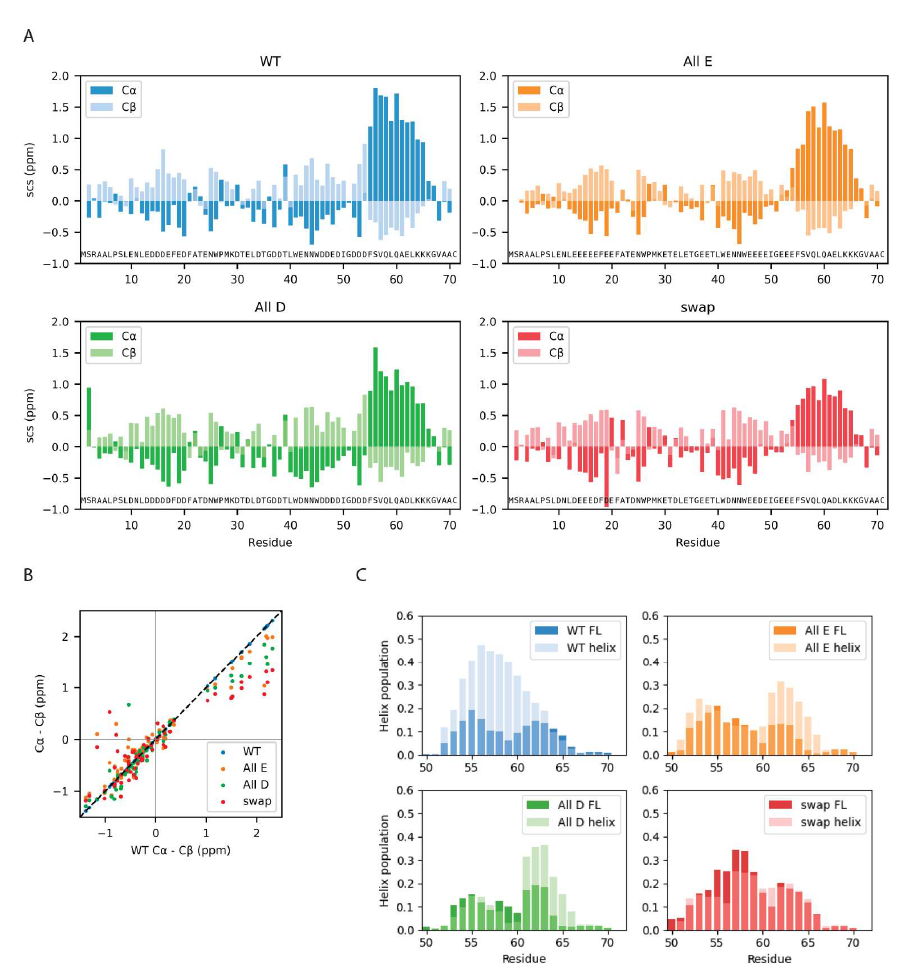
Figure 6. Local chain properties of Dss1 WT, All-E, All-D and Swap. ( A ) NMR secondary chemical shifts (C α and C β ) for Dss1 wildtype and the three variants; ( B ) correlation between SCSs of WT Dss1 and the three variants; ( C ) helix population of the C-terminal region from MD simulations of full- length (FL) Dss1 overlayed with the helix population from the simulations of the helix region alone.